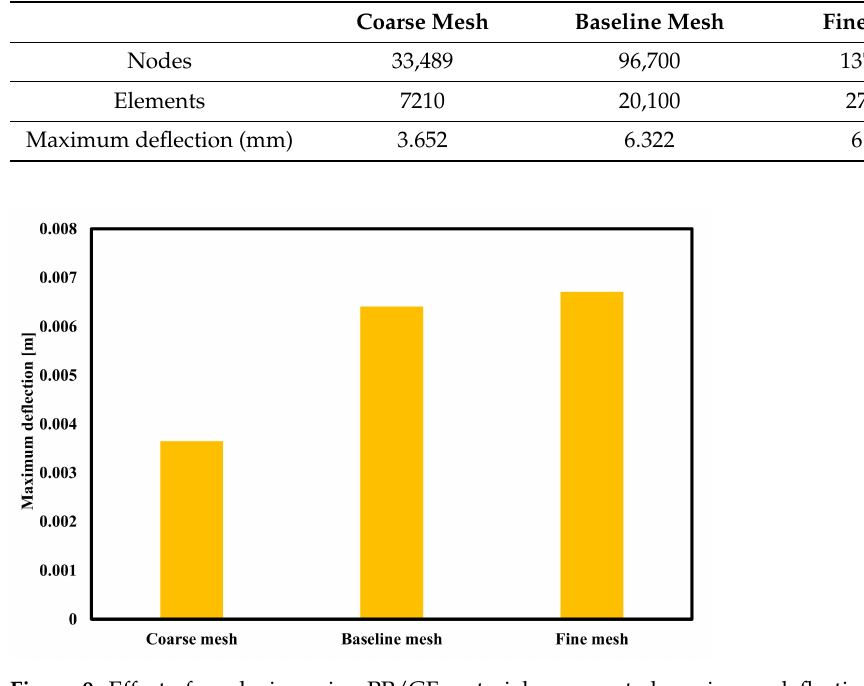
Figure 9. Effect of mesh size using PP/GF material on expected maximum deflection for highest rotational velocity of 26.22